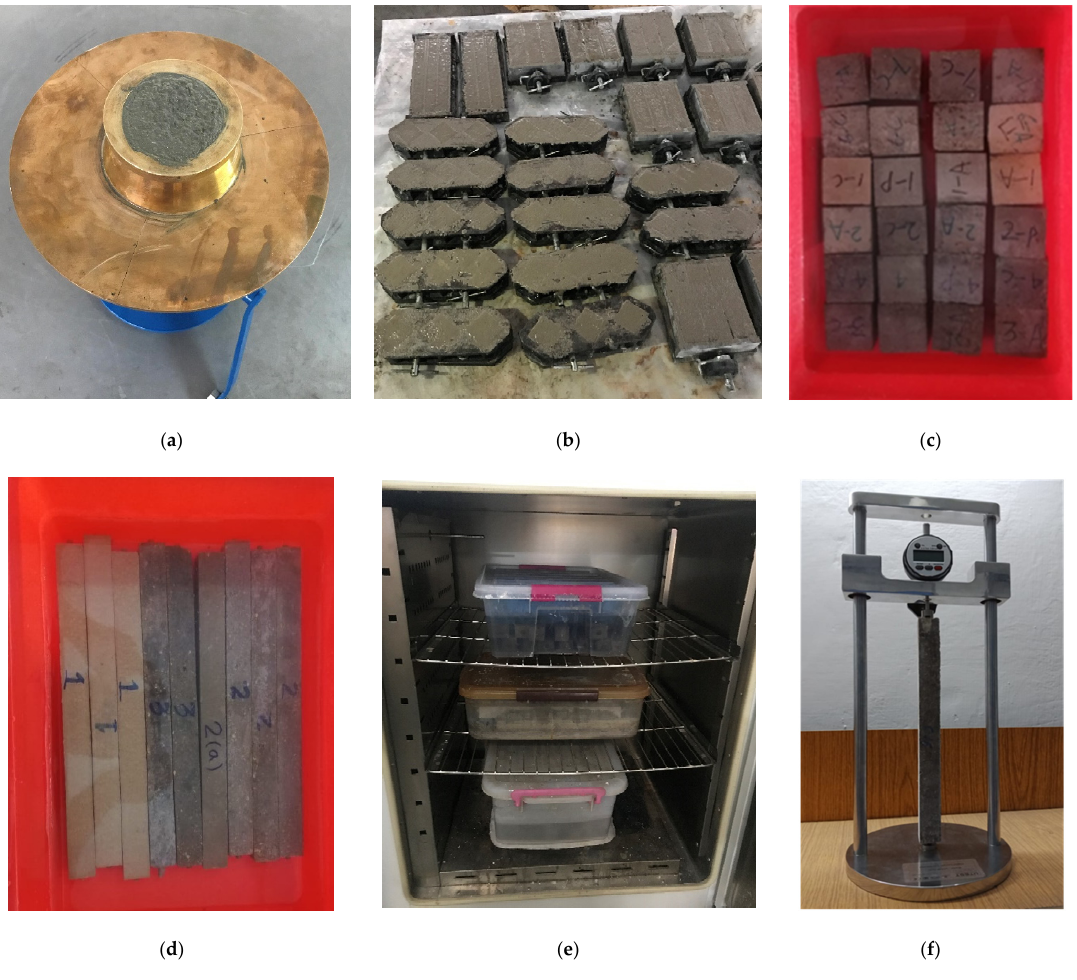
Figure 3. Specimen preparation and testing: ( a ) flow table; ( b ) specimen placed on vibratory table; ( c ) cubes placed in water; ( d ) mortar bar placed in NaOH solution; ( e ) specimens in oven; ( f ) length change measurement.